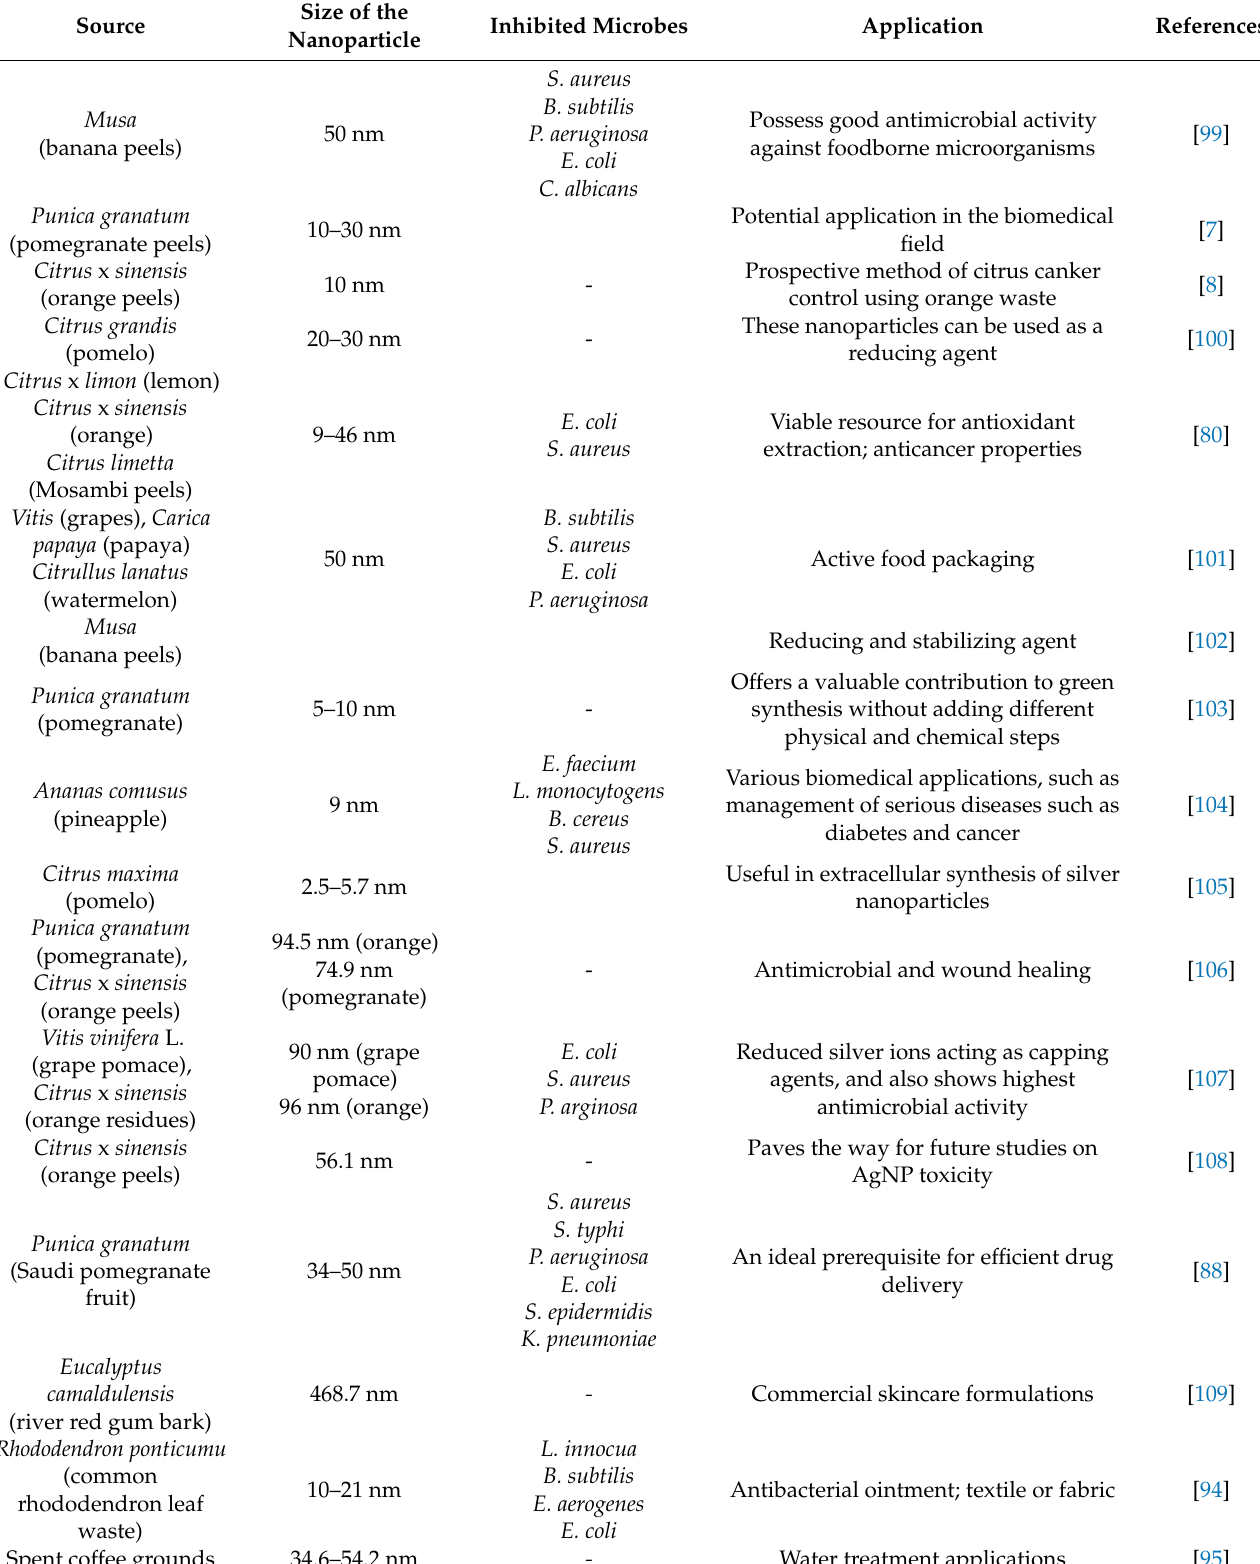
Table 3. The various biowastes used in the green biological synthesis of silver nanoparticles.